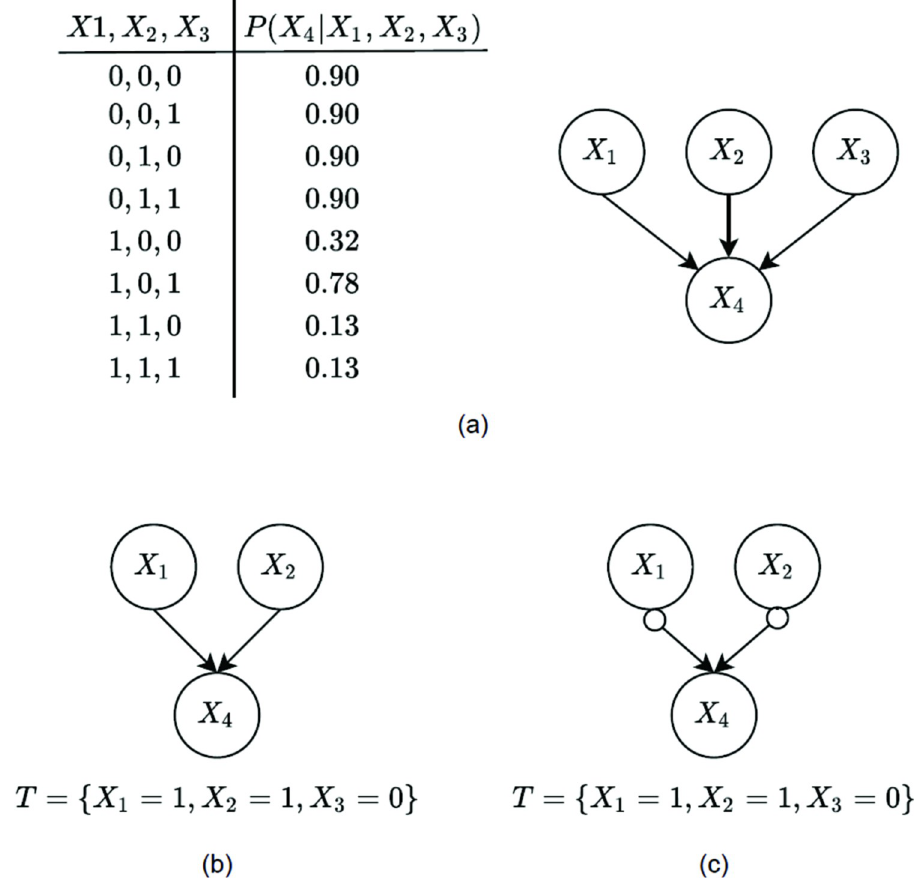
Fig 11. A simple, hypothetical example of CSI. ( a ) The data-generating CBN for variable X 4 given its parents X 1 , X 2 , X 3 ; ( b ) the individualized CBN that represents the CSI relationship X 4 ? X 3 |( X 1 = 1, X 2 = 1); ( c ) the individualized PAG that is learnable in the large sample limit from observational data generated by the CBN in b , given the assumptions described